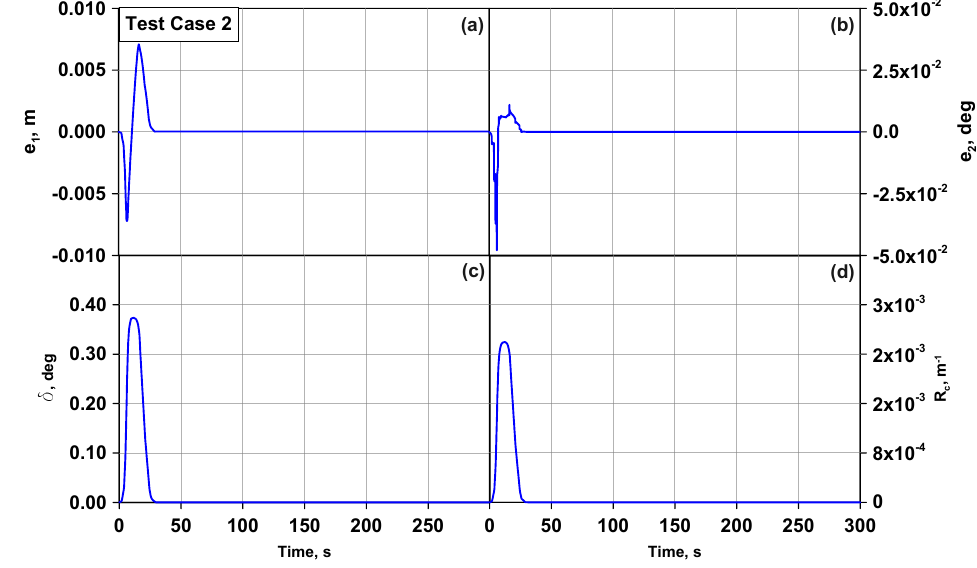
Figure 10. Test case 2: ( a ) lateral displacement (m); ( b ) yaw angle error (deg); ( c ) steering angle at the wheels (deg); ( d ) road curvature (m − 1 ).